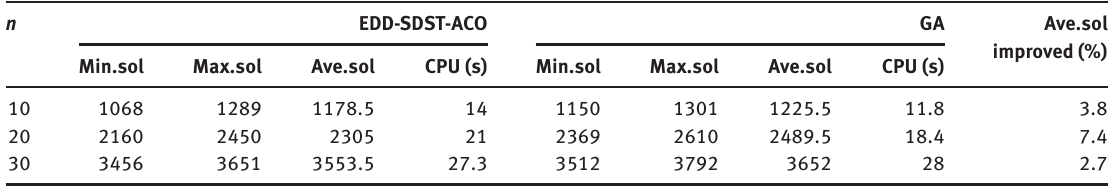
Table 8: Comparison between the Results of EDD-SDST-ACO Algorithms and GA.